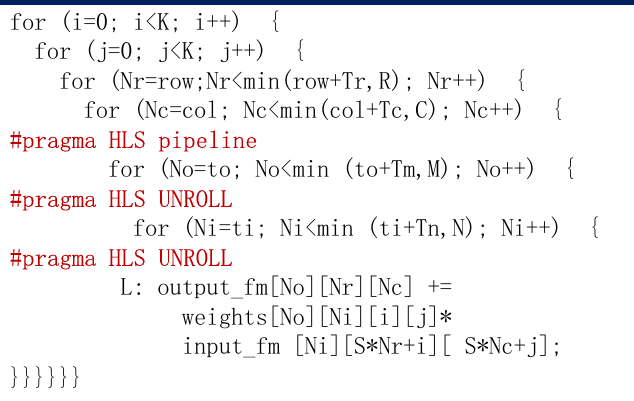
Figure 8. Structure of automatic signal modulation recognition (AMR) IP implemented using an RFNoC framework. 4. Results 4.1. Use of Resources Through experiments in TensorFlow, we used some of these software components to construct an optimized AMR structure as shown in Figure 4 and Table 2. In the AMR, the total number of weights was 2,830,427. Each weight was a 32-bit fixed-point number and therefore, occupied 90,573,664 bits of storage. We completed the pre-training of the AMR on a workstation with the Xeon E-1600V4 CPU, operating frequency of 3.5 GHZ, and RAM capacity of 16 GB. The operating system